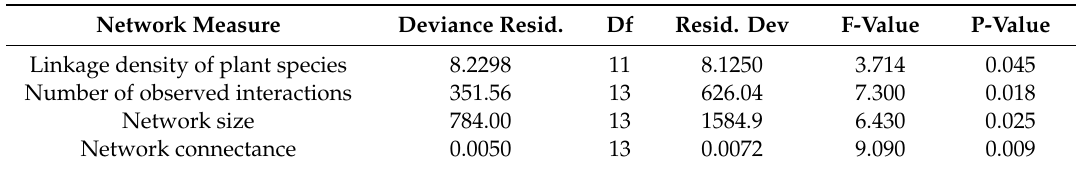
Table 1. Generalized linear models showing the e ff ects of occurrence of superhost plants on the network structure of plant–galling insect networks in Brazilian